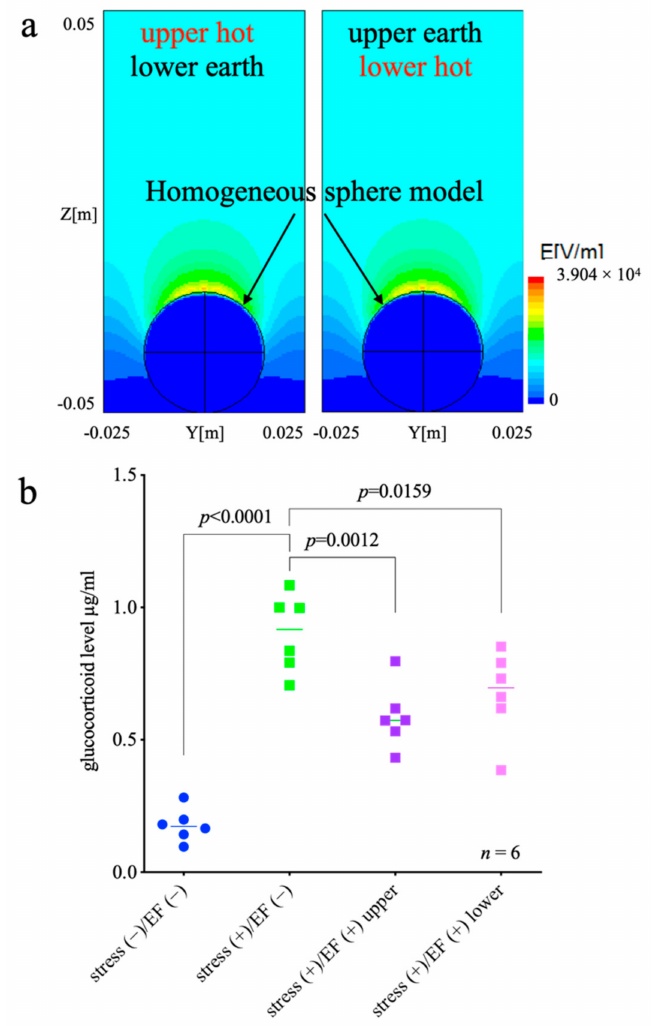
Figure 6. Effect of the polarization of the electrode on the suppressive effect of EF, Experiment 2. ( a ) The distribution of the electric field (EF) on the mouse’s body. ( b ) One-way ANOVA, F (DFn, DFd) = F (3, 20) = 32.97, the p -value < 0.0001. Subsequently, Dunnett’s multiple comparisons test indicated that the p -value between stress (+)/EF ( − ) vs. stress (+)/EF (+) upper is 0.0012, and the p -value between stress (+)/EF ( − ) vs. stress (+)/EF (+) lower is 0.0159. The EF was found to reduce the immobilization-induced increase in GC levels in immobilized mice, regardless of which electrode EF was loaded